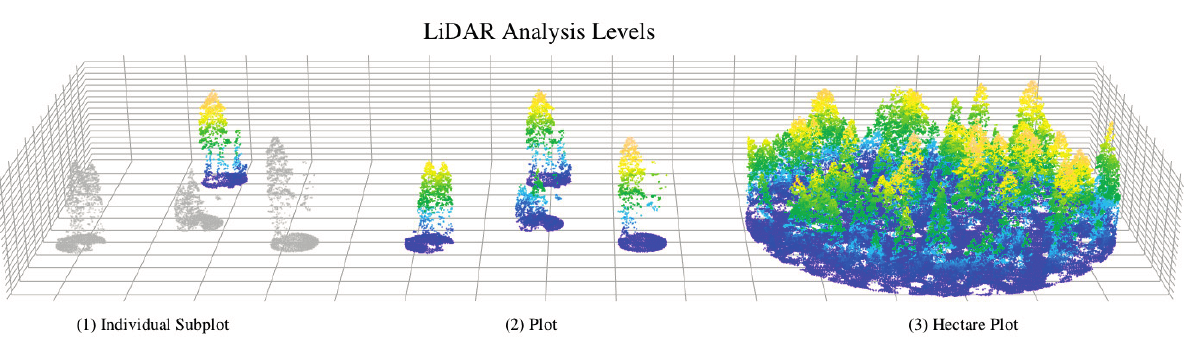
Figure 3. Light detection and ranging (LiDAR) analysis levels. Point clouds were extracted for individual subplots, clusters of four subplots, and hectare